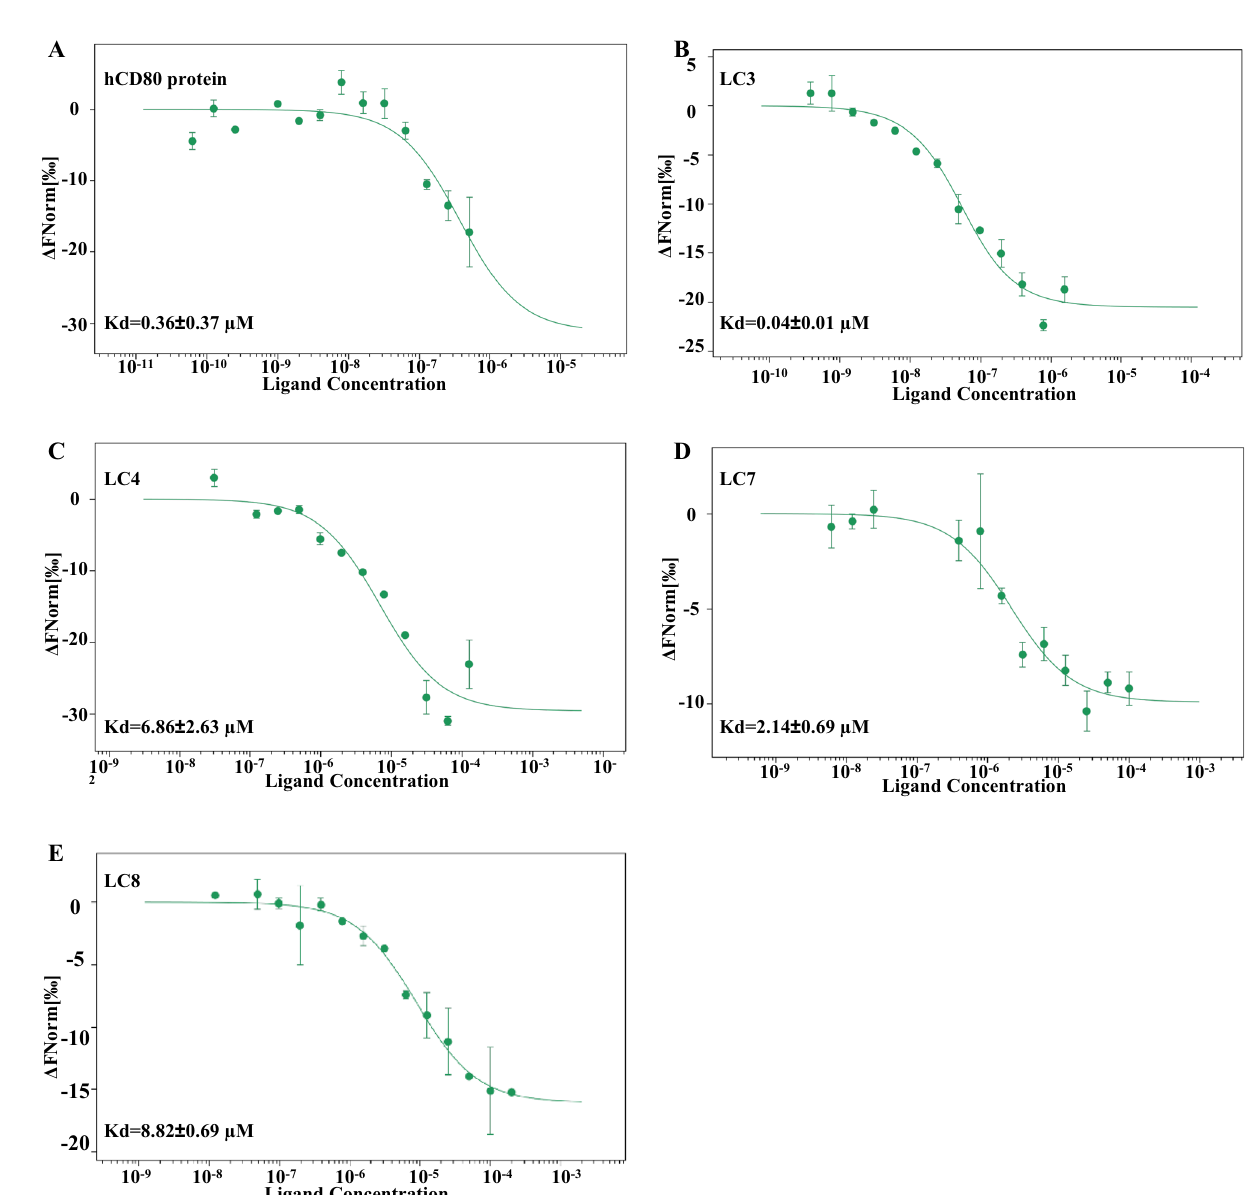
Fig. 1 Binding peptide to hCTLA-4 protein detection by MST. A – E The MST binding curves of human CTLA4 binding peptides to